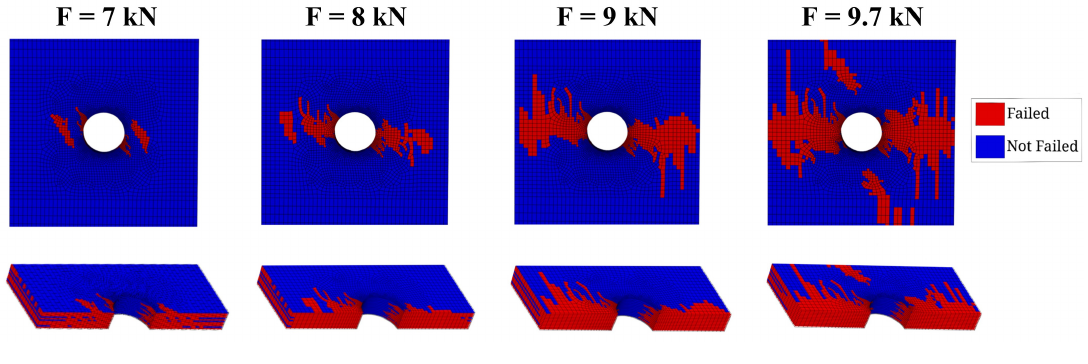
Figure 7. IFF pattern progression prediction.